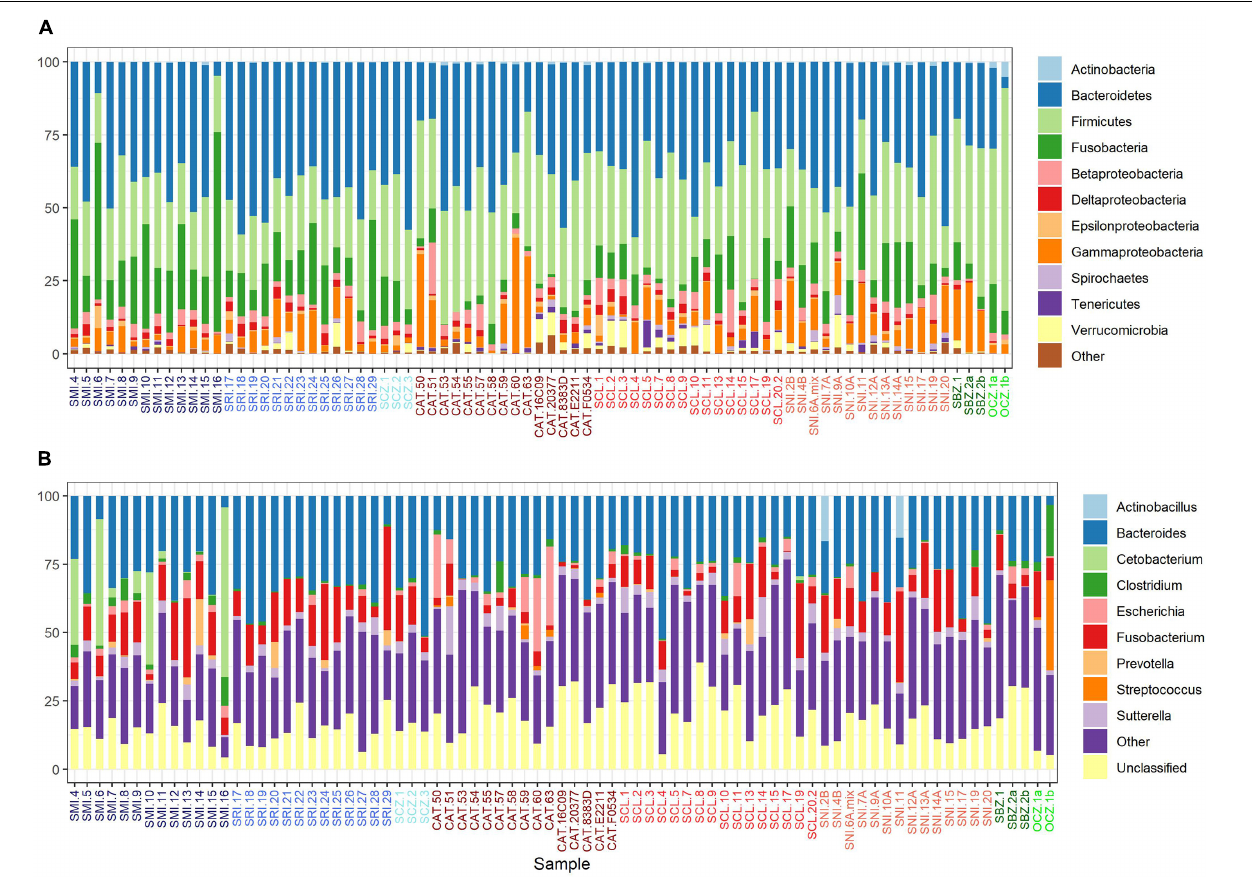
FIGURE 2 | Percent relative abundance of the major taxa (A) and genera (B) recovered from U. littoralis scat per sample. Sample names are colored by source (island or